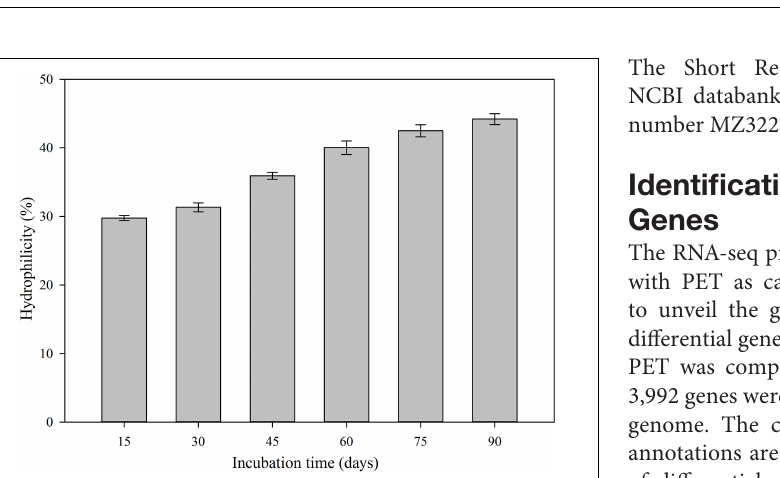
FIGURE 4 | The hydrophilicity of bacterial treated PET surface during the incubation